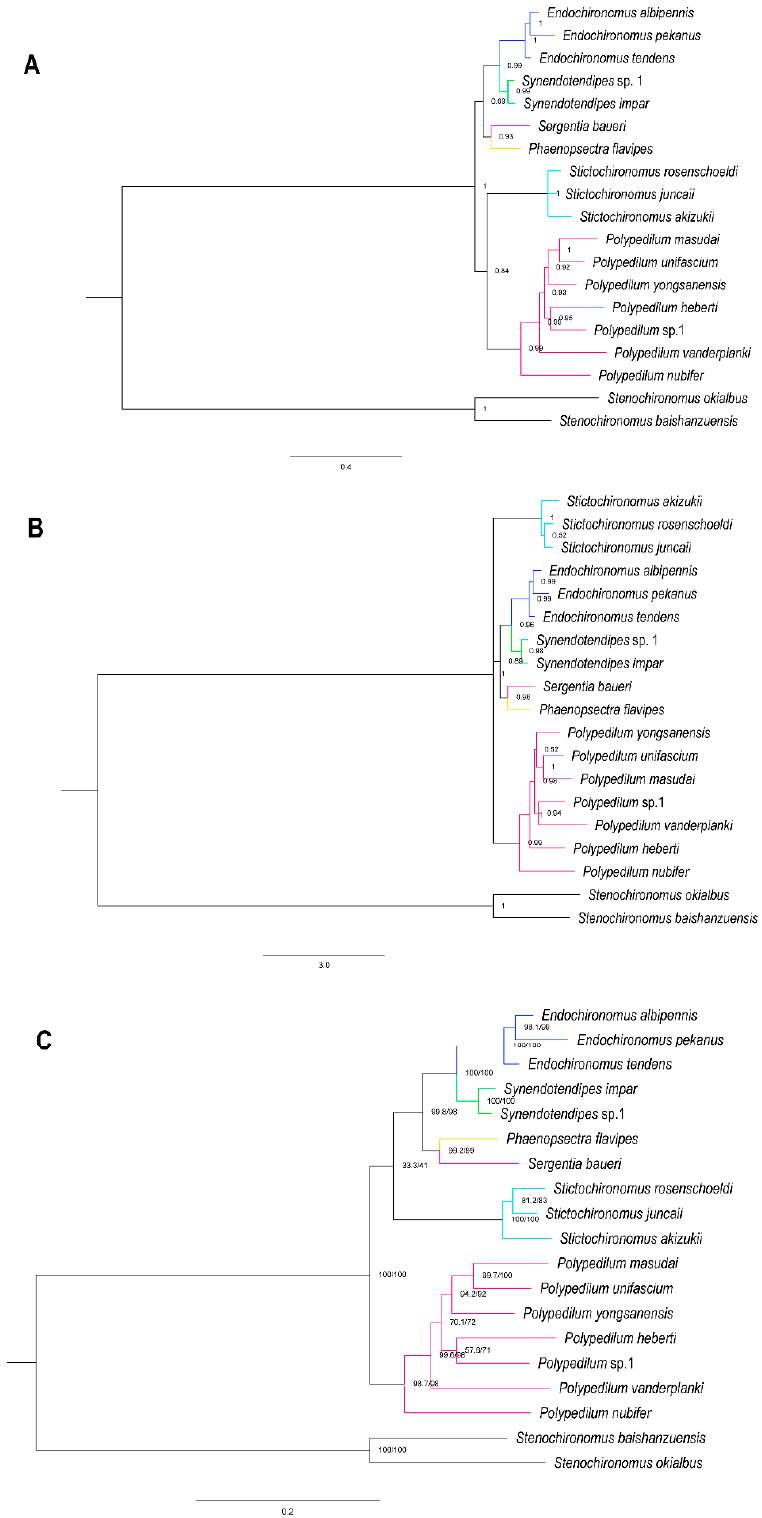
Figure 5. Phylogenetic trees of the Polypedilum generic complex: ( A ) BI tree based on analysis cds_fna in Phylobayes. ( B ) BI tree based on analysis of cds_rrna in Phylobayes. ( C ) ML tree based on the anaysis cds_faa with PMSF model in IQTREE. Support values on nodes indicate Bayesian posterior probabilities in topology A and B, while they represent SH-aLRT/UFBoot2 in topology C.